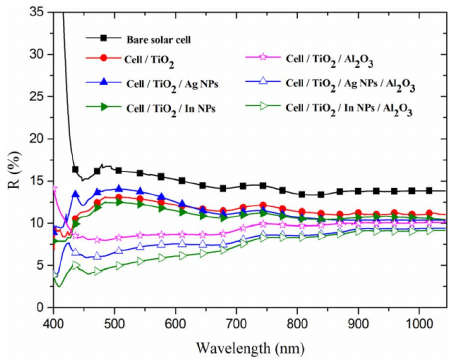
Figure 5. Optical reflectance ( R ) of bare textured c-Si solar cell, cell with TiO 2 spacer layer, cell with double layer of TiO 2 /Al 2 O 3 , cell with In-NPs on TiO 2 spacer layer, cell with Ag-NPs on TiO 2 spacer layer, cell with In-NPs embedded in TiO 2 /Al 2 O 3 , and cell with Ag-NPs embedded in TiO 2 /Al 2 O 3 .